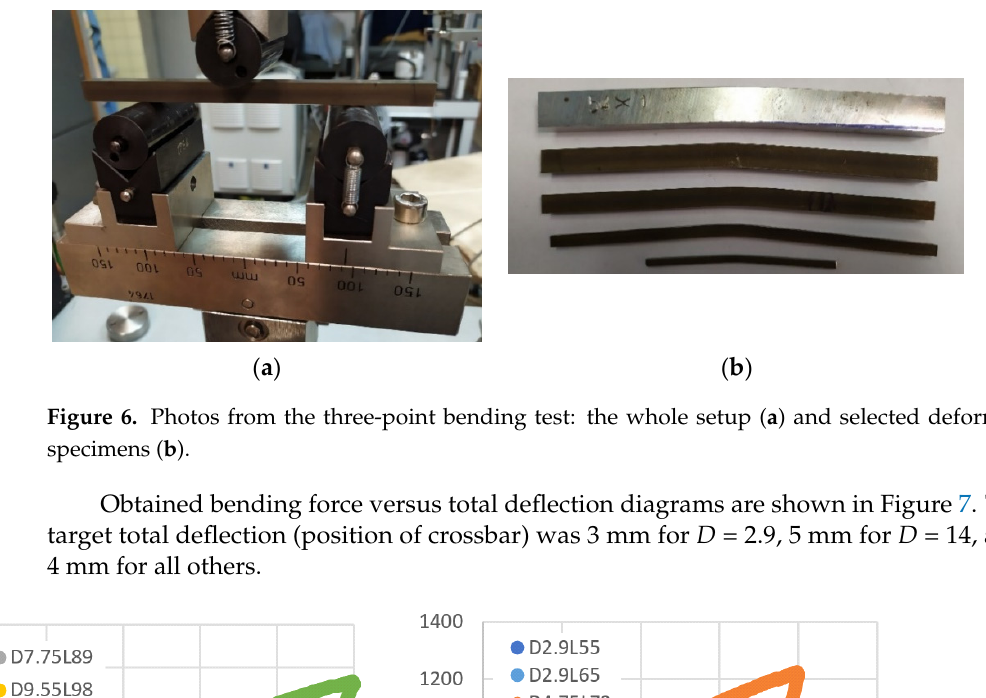
Figure 5. The dependency of the optimal distance of supports L on cross-section size D. FEM, fi- nite element method.